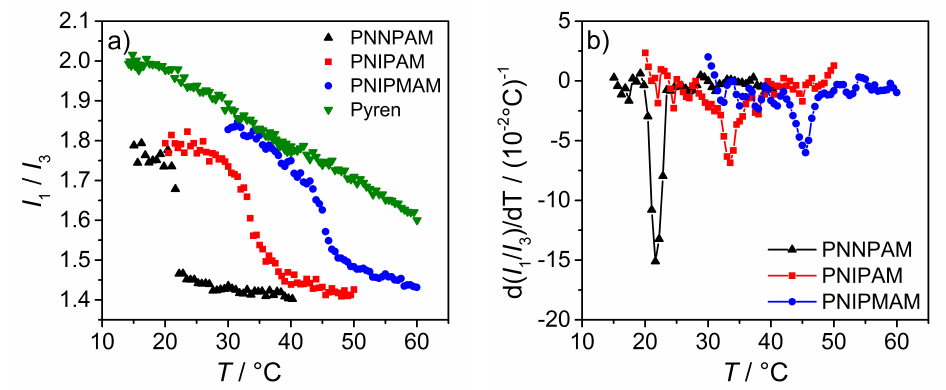
Figure 12. ( a ) Plot of the intensity ratio I 1 / I 3 as a function of temperature for PNNPAM, PNIPAM and NIPMAM solutions mixed with pyrene as well as pure pyrene as reference; ( b ) To quantify the VPTT, the first derivative of I 1 / I 3 with respect to temperature as a function of temperature is presented. The concentration of all microgel solutions was